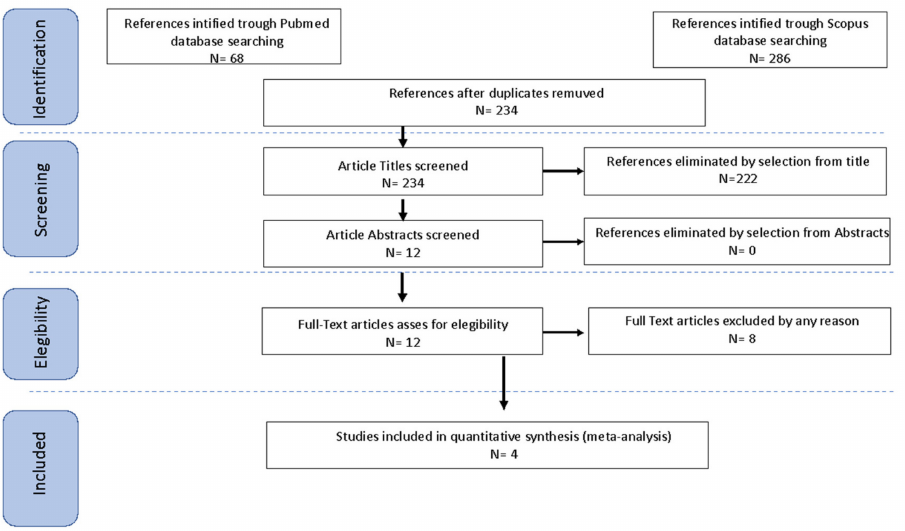
Figure 1. PRISMA